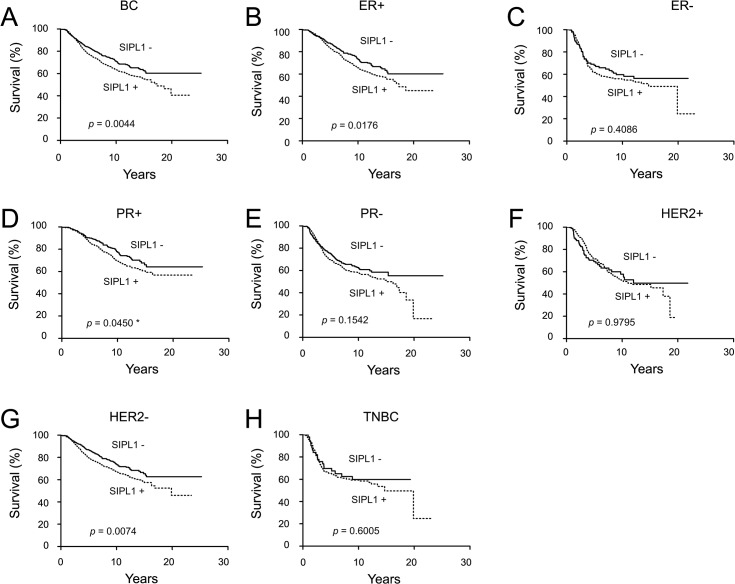
Increases in SIPL1 gene copy number correlate with decreased survival for patients with breast cancer.Data was extracted from the Curtis dataset within Oncomine and analyzed with respect to gene copy number variation. Specifically, SIPL1 copy number above 2 was labelled as SIPL1+ and those below 2 were indicated as SIPL1-. Kaplan–Meier analysis of survival for a subset of patients with SIPL1 amplified breast cancer vs. those with breast cancer without SIPL1 amplification (A, n = 1118 for SIPL1+ BCs, n = 127 for SIPL1- BCs), ER+ (B, n = 810 for SIPL1+ BCs, n = 92 for SIPL1- BCs), ER- (C, n = 295 for SIPL1+ BCs, n = 35 for SIPL1- BCs), PR+ (D, n = 565 for SIPL1+ BCs, n = 64 for SIPL1- BCs), PR- (E, n = 553 for SIPL1+ BCs, n = 63 for SIPL1- BCs), HER+ (F, n = 291 for SIPL1+ BCs, n = 27 for SIPL1- BCs), HER- (G, n = 822 for SIPL1+ BCs, n = 100 for SIPL1- BCs), and TNBC (F, n = 163 for SIPL1+ BCs, n = 21 for SIPL1- BCs). Only patients with follow up survival data were included. Any patients whose death was not related to the disease or with a non-specified cause were excluded. Statistical Analysis was conducted using a Log-Rank test. A p-value of <0.05 was considered statistically significant.